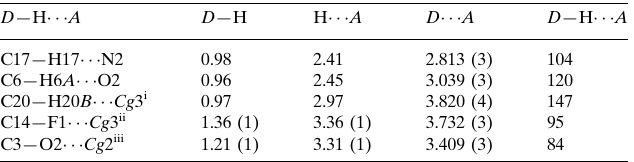
Data collection: SMART (Bruker, 2001); cell refinement: SAINT- Plus (Bruker, 2001); data reduction: SAINT-Plus ; program(s) used to solve structure: SHELXS97 (Sheldrick, 1997); program(s) used